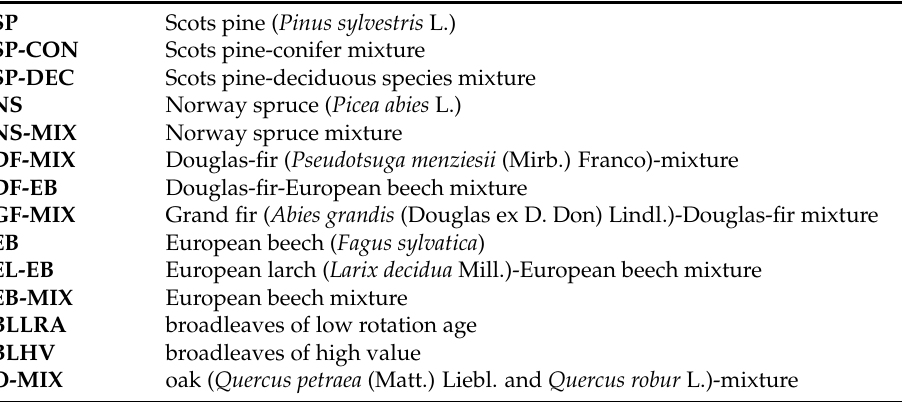
Table 4. Abbreviations for stand types used throughout the